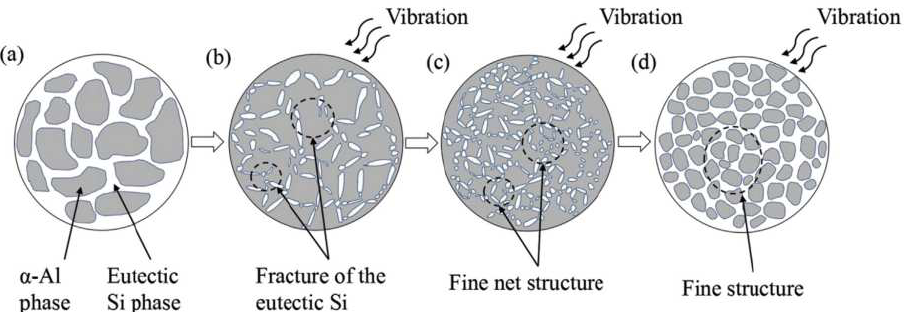
Figure 9. Evolutionary process of the fine microstructure obtained under high-frequency micro-vi- brations: ( a ) molten liquid phase before solidification; ( b ) fracture of the eutectic Si under high-frequency micro-vibrations; ( c ) fine eutectic Si obtained by high-frequency micro-vibrations; ( d ) fine-grained and compact structure in the alloy [67].